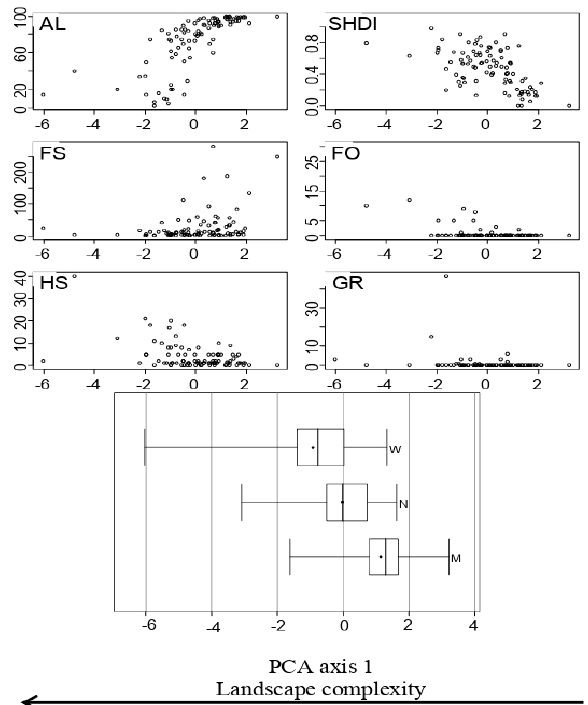
Figure 1. Landscape variables significantly associated with PCA axis 1. AL = arable land cover, SHDI = Shannon diversity index of land-use types, FS = field size, FO = woodland cover, GR = annual grassland cover, HS = cover of human settlements, and width = margin width class, N: narrow margins ( < 1 m), M: Medium-sized margins (1–2 m), W: wide margins ( > 2 m). Boxplots show median values (bold line) and mean (dot); box limits represent lower an upper quartiles, and whiskers represent the minimum and maximum values.